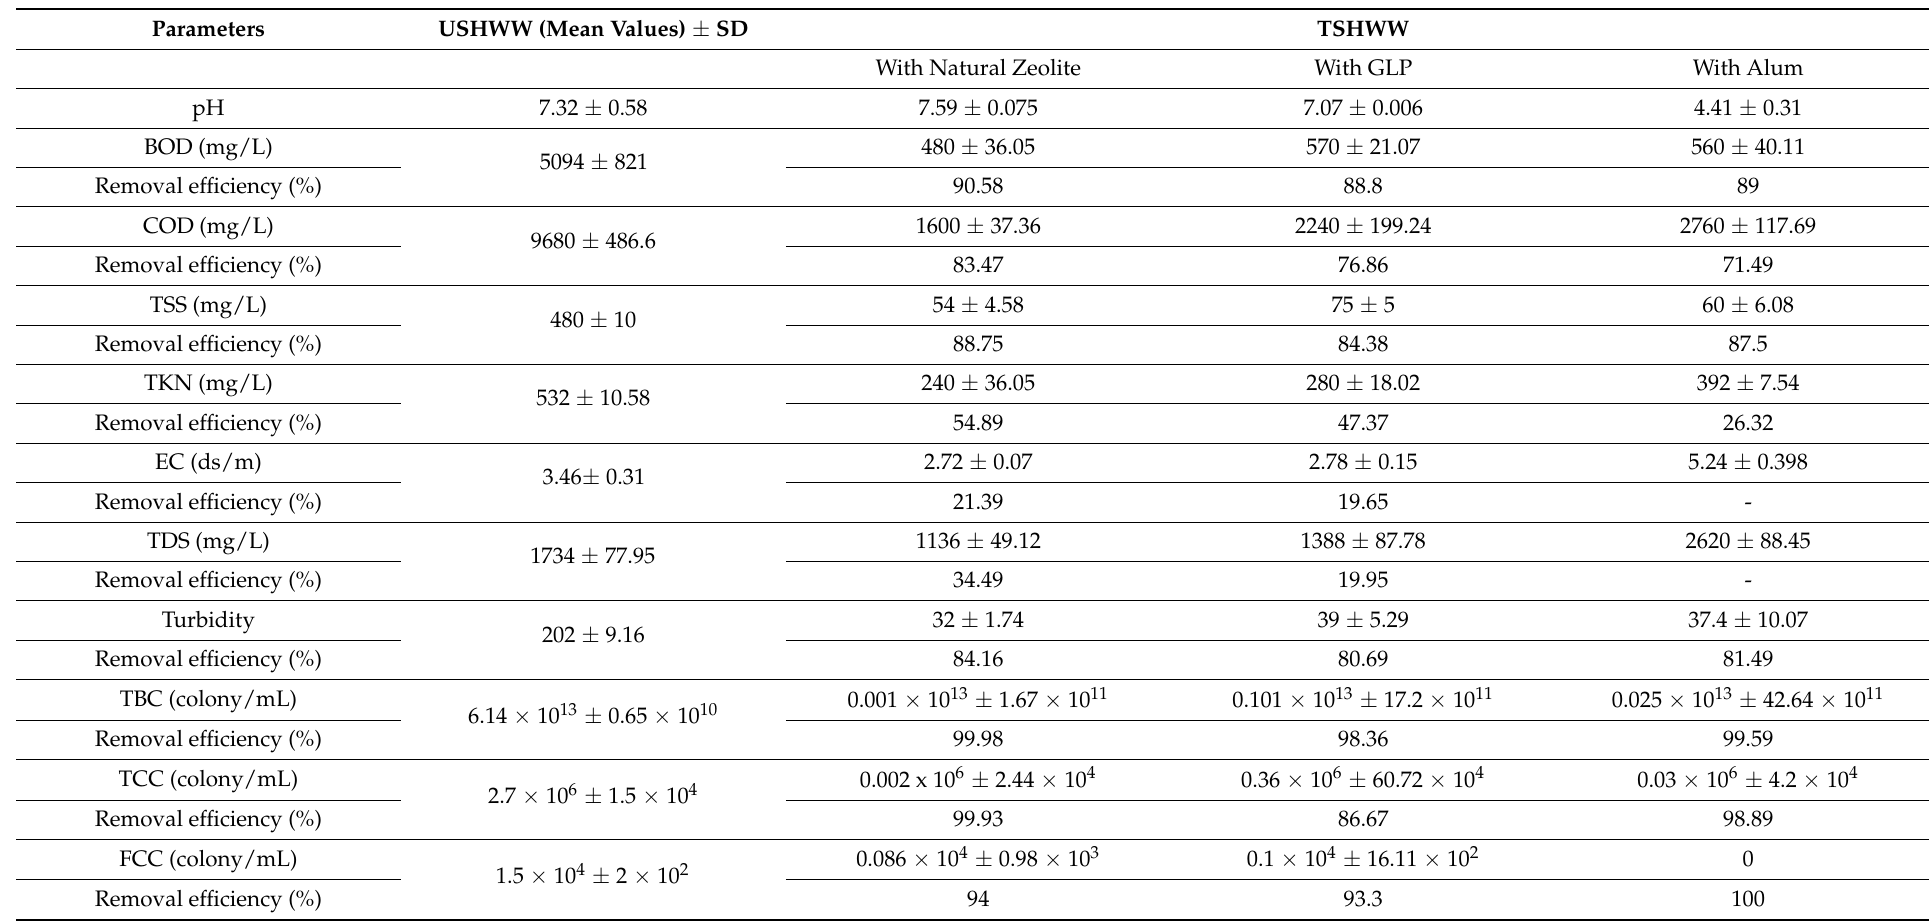
Table 6. Average physicochemical and bacteriological characteristics of untreated (USHWW) and treated slaughterhouse wastewater (TSHWW) ( ±